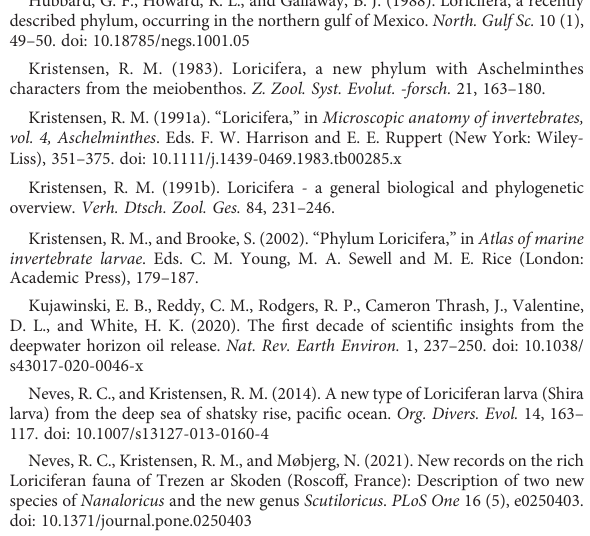
Light micrographs of the adult (of uncertain genus) of an undescribed species of Nanaloricidae. (A) Overview of the specimen. Dorsal view, anterior faces up. (B) Anterior region of the body. Note the location of the pharyngeal bulb inside the mouth